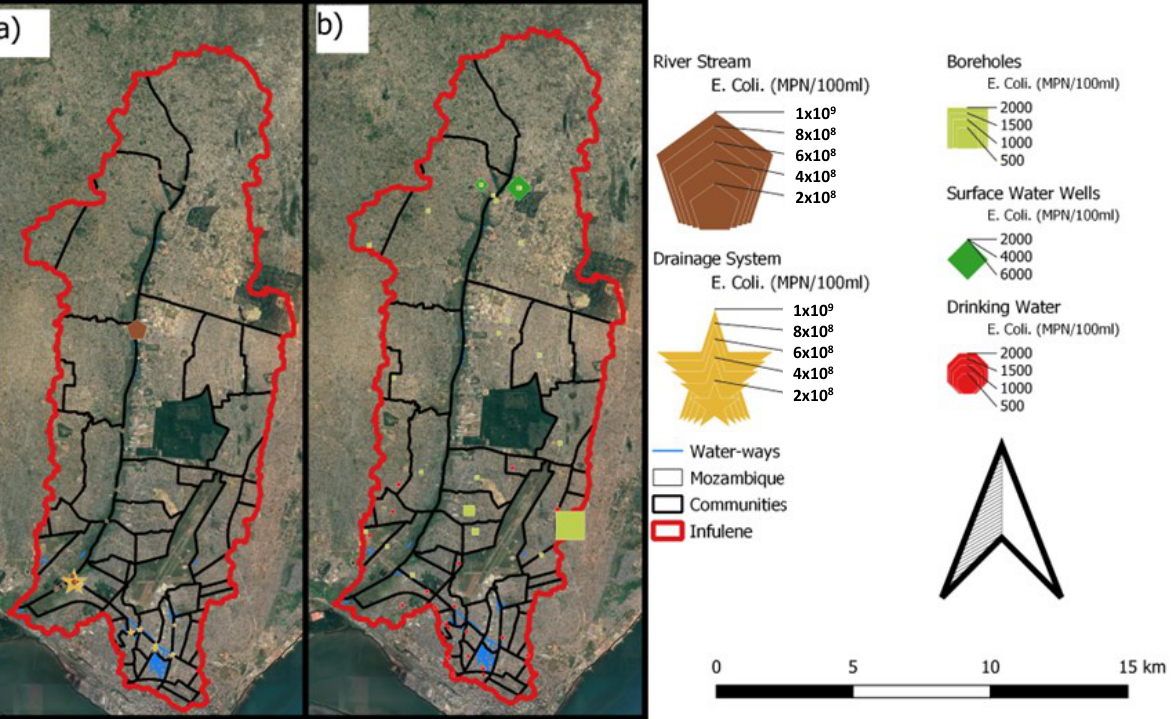
Figure 9. Spatial analysis of concentration of E. coli , considering separately ( a ) the river water with drainage water and ( b ) the drinking water .